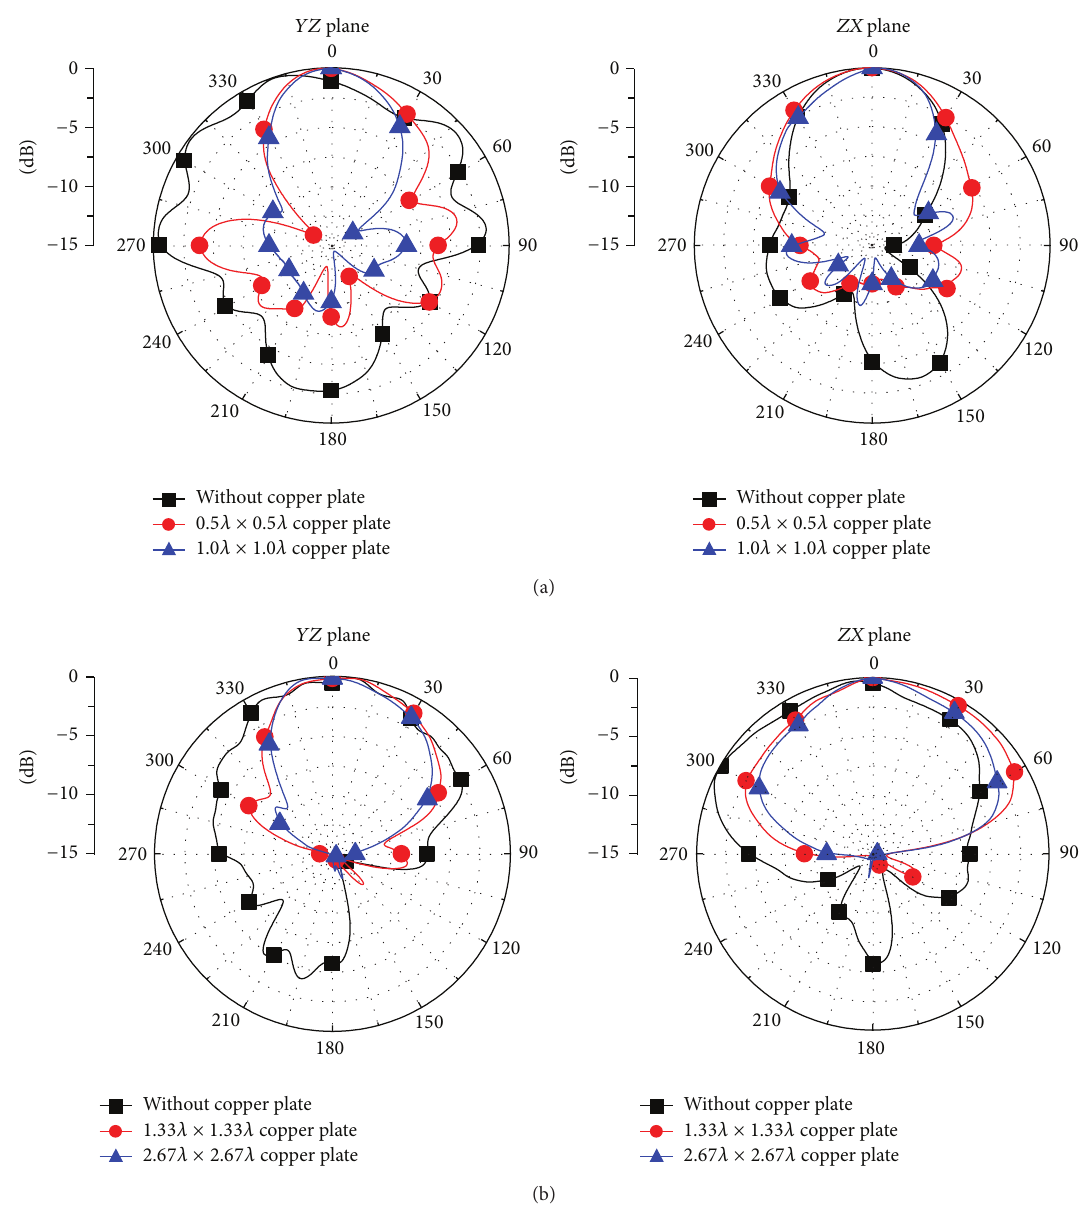
Figure 9: Measured radiation patterns of the proposed antenna mounted on the different sized metallic objects: (a) 920MHz and (b) 2.425